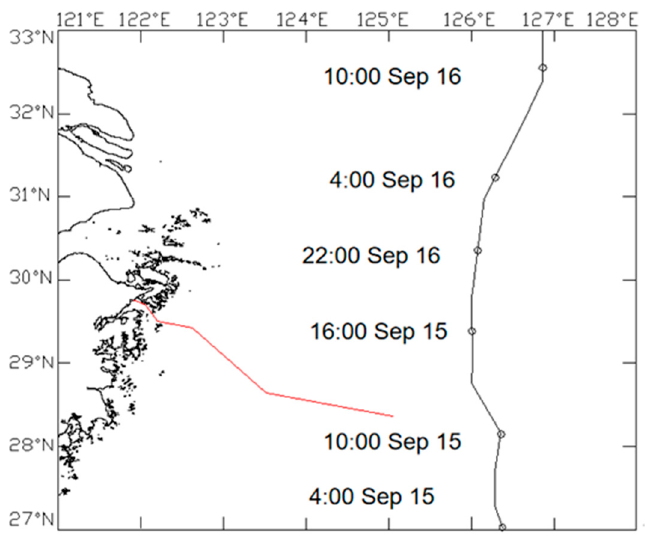
Figure 6. The path of Typhoon Lily (Beijing time).